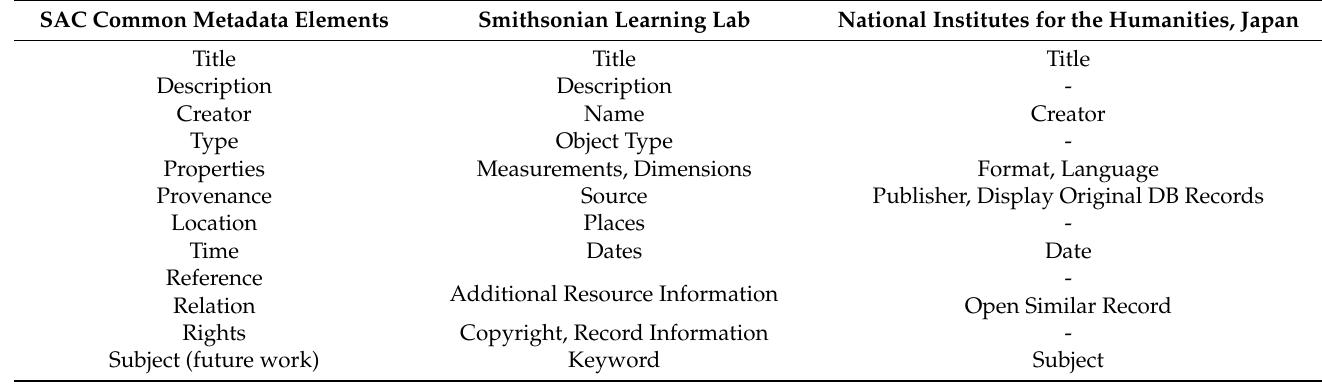
Table 4. Comparison of the SAC common metadata elements and those of the reference systems.